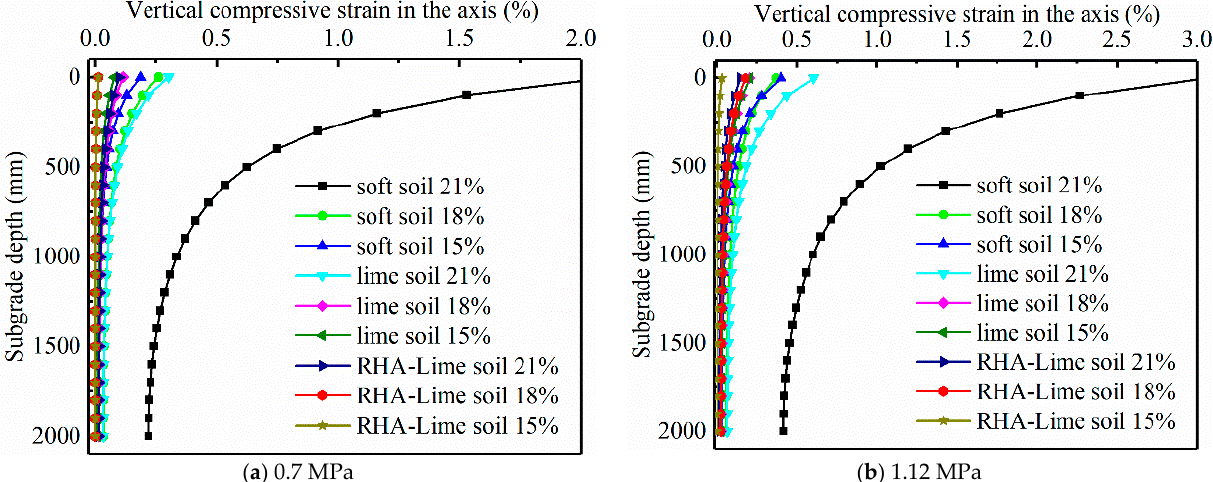
Figure 15. Distribution of vertical compressive creep strain in the subgrade. The depth of the effective deforming zone of a soil foundation is set as the location where the stress is 1/10 of the gravity stress [52]. The creep deformations of the three types of soils under different stress conditions with different water contents are obtained. Figure 16 present the results. δ t is the creep deformations of subgrade; is the creep time; and h is depth of where s the effective deforming zone of the subgrade.